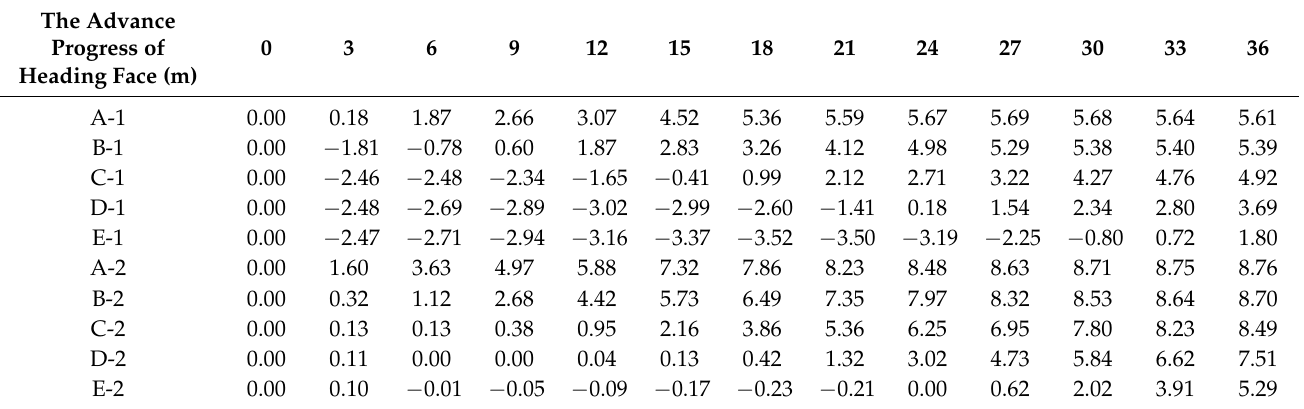
Table 8. Settlement deformation trend of the arch bottom (Unit: